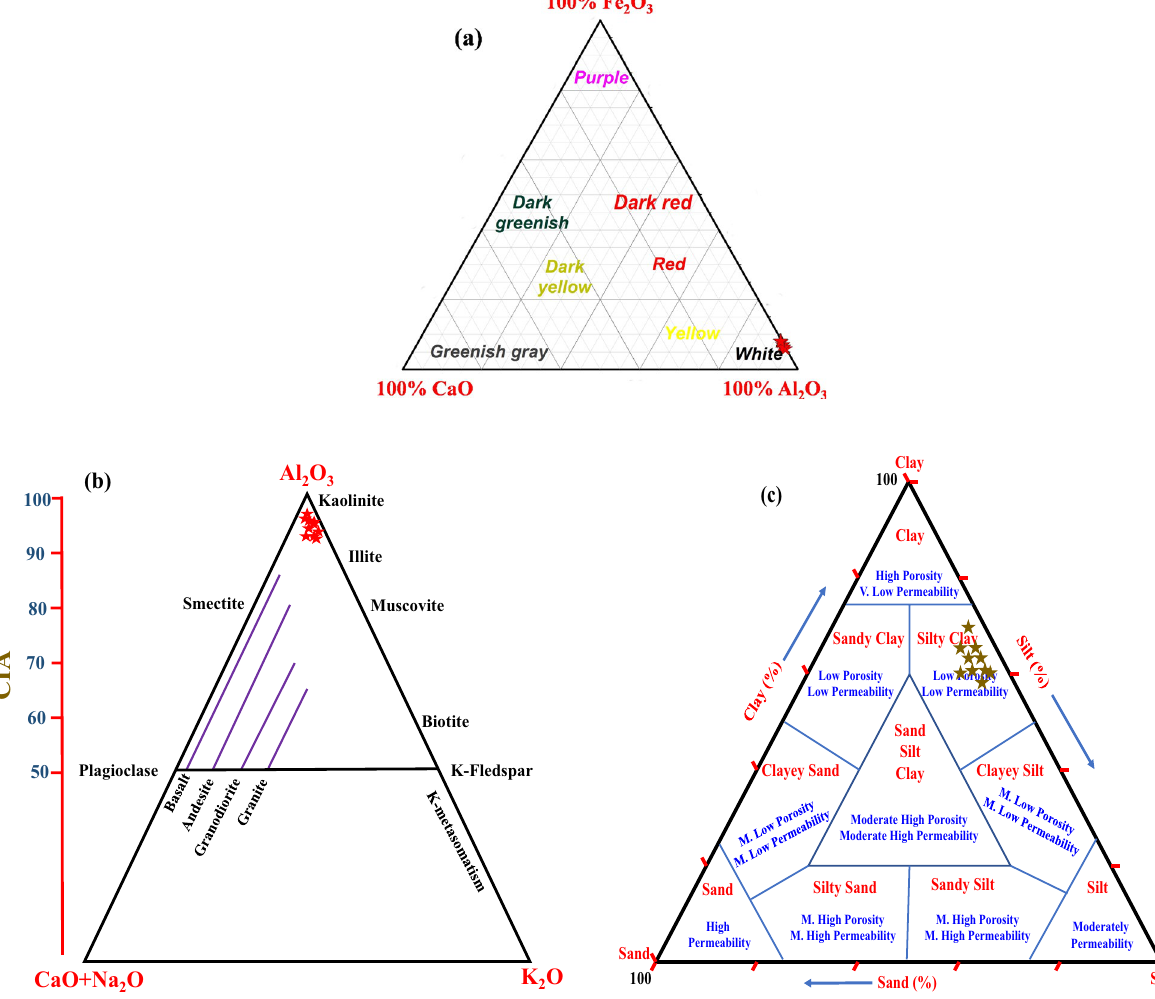
Figure 5. Illustrates: ( a ) The three-component diagram showing fired brick color differences (after (Piltz (1964) 56 ), ( b ) CIA ternary diagram (after Nesbitt and Young (1982, 1984) 63,64 ), ( c ) Textural classification of studied clay sediments following the relation between sand, silt and clay components and their controls over porosity and permeability (after Shepard (1954) 70